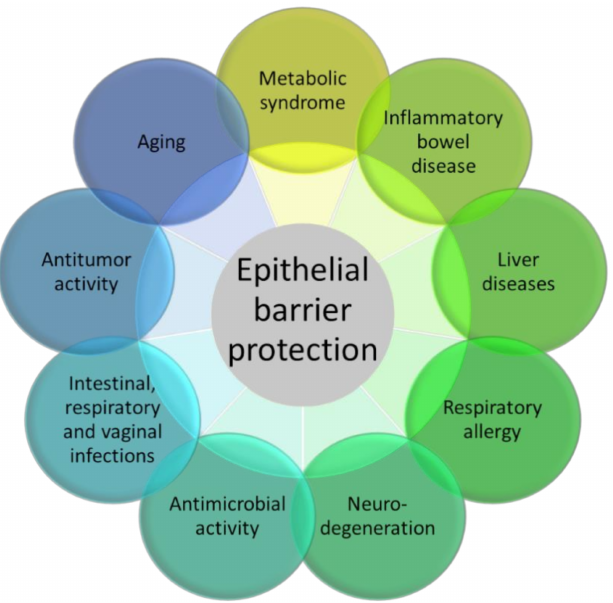
Figure 2. The figure represents the many experimental pathology models in which 3-IAld has shown beneficial activity, essentially moving from its epithelial barrier protection